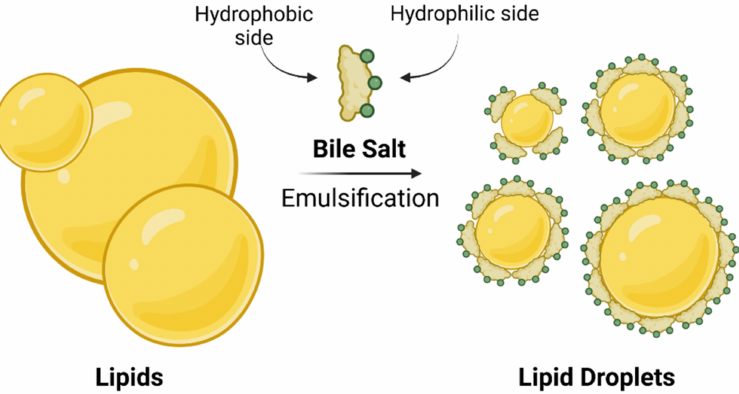
Figure 2. Simplified model of lipid solubilization in aqueous environment. Created with